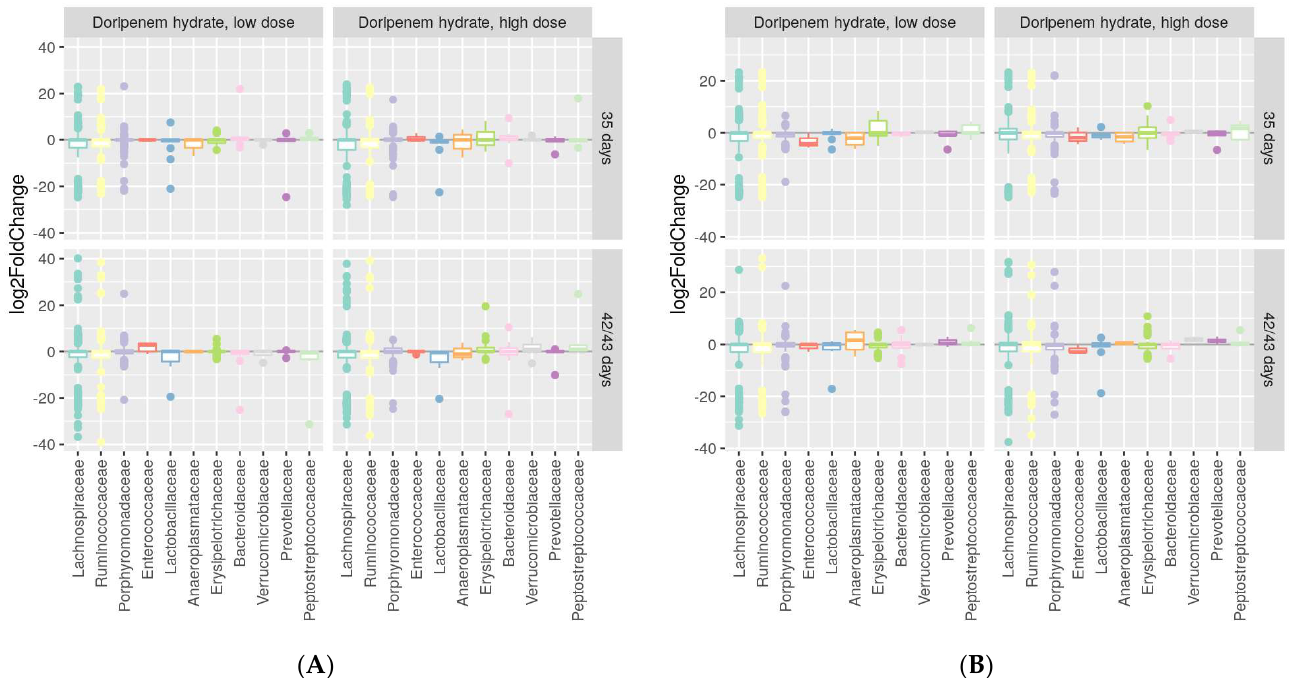
Figure 7. Differential abundances in dominant bacterial families one and two weeks post-doripenem-treated samples from the low- (LD) and high- (HD) dose groups relative to the controls for males ( A ) and females ( B ). Differential abundance analysis was performed using log2FC (log2 fold change) values.